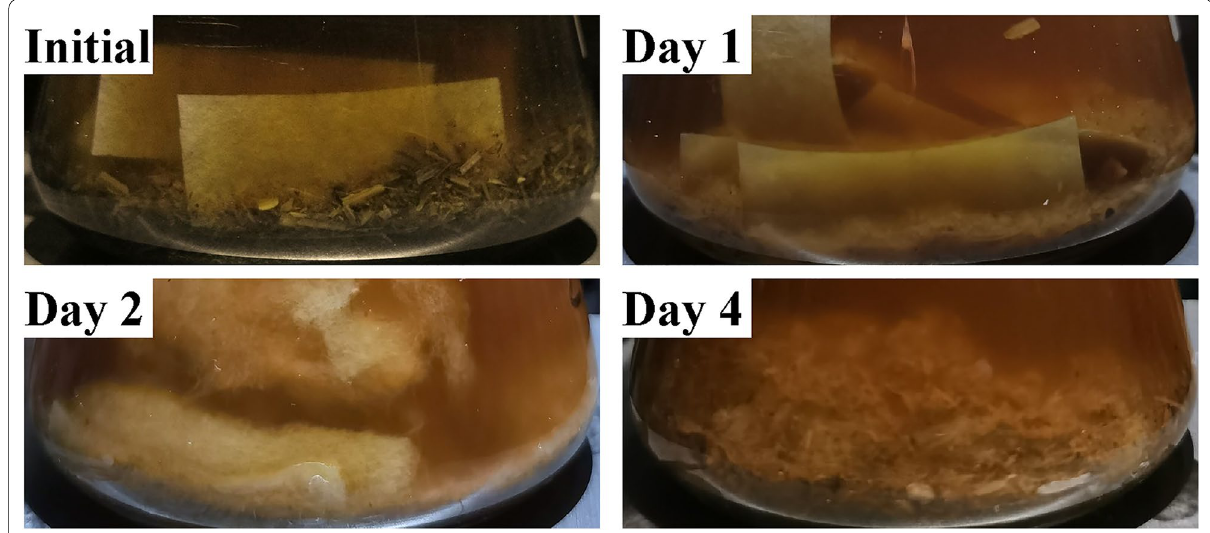
Fig. 1 Degradation of filter papers during consortium